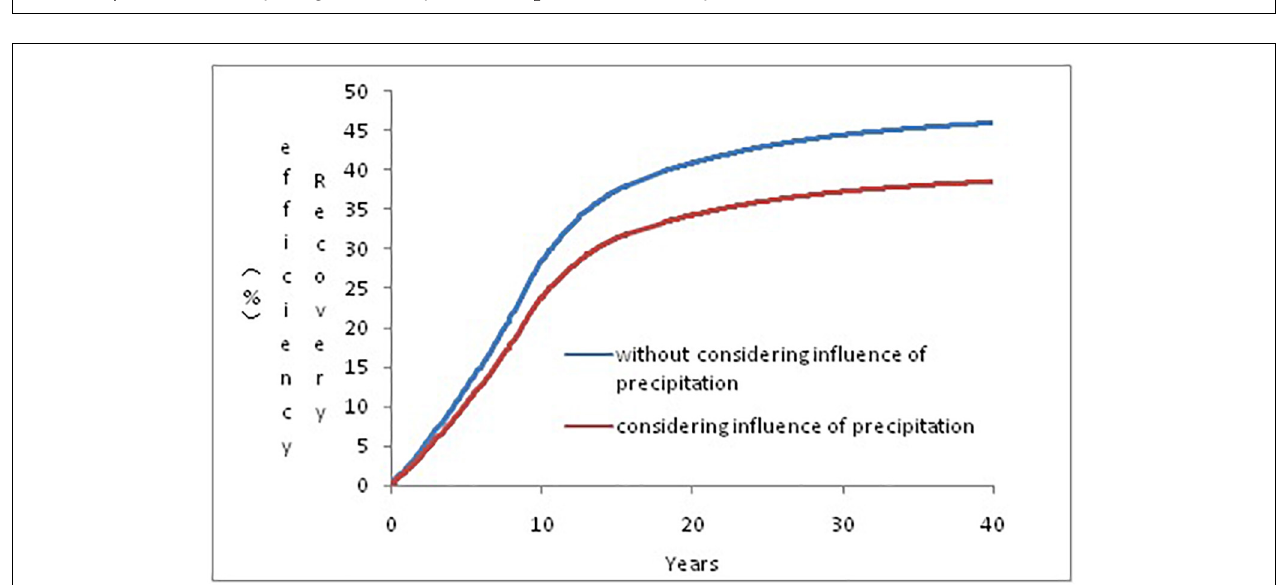
FIGURE 7 | Coefficient of fluidity change at the 40th year of the CO 2 enhanced oil recovery.